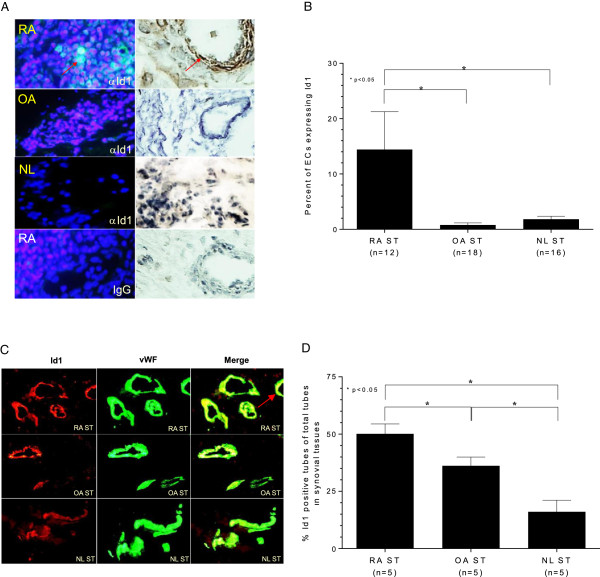
IF was performed on RA, OA, and NL ST sections: A) For IF histology, samples were incubated with mouse anti-human Id1 antibody then followed with a fluorescent conjugated secondary antibody. Samples were stained with DAPI (blue) and images merged. Id1 expression is clearly shown in green (images were taken at 400×). IHC was also performed on RA, OA, and NL ST sections as described. As shown, Id1 could be seen up-regulated in RA vascular tissue by IF staining and IHC. B) The percentage of cells expressing Id1 were analyzed on ECs with a significantly higher percentage of Id1 expressing ECs in RA compared to NL and OA ST (n = number of patients). C) For merged IF histology, samples were incubated with mouse anti-human Id1 and rabbit anti-human vWF antibodies. This was followed by fluorescent conjugated secondary antibodies and images were merged. Id1 expression is clearly shown in red and vessels as defined by vWF expression are shown in green (images taken at 400×). Merged vessel regions shown in yellow are due to Id1 expressing EPCs. D) The percentages of Id1 positive tubes in each of the tissues were calculated and graphed. Id1 containing vasculature was significantly higher in RA compared to NL and OA ST (400×, n = number of patients).